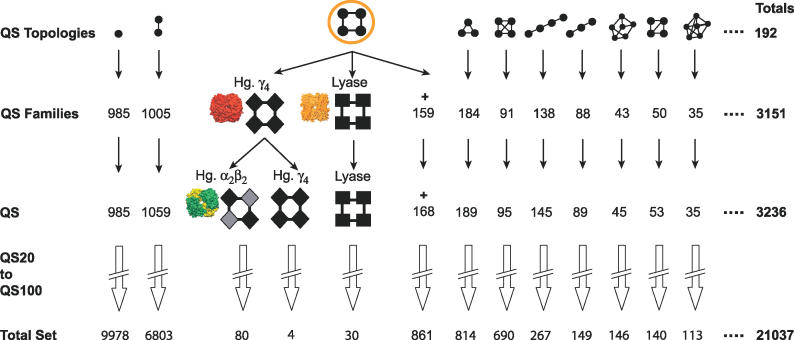
A Hierarchy of Protein Complexes of Known Three-Dimensional StructureThe hierarchy has 12 levels, namely, from top to bottom: QS topology, QS family, QS, QS20, QS30…QS100. At the top of the hierarchy, there are 192 QS topologies. One particular QS topology (orange circle) with four subunits is expanded below. It comprises 161 QS families in total, of which two are detailed: the E. coli lyase and the H. sapiens hemoglobin γ4. All complexes in the E. coli lyase QS family are encoded by a single gene and therefore correspond to a single QS. However, the hemoglobin QS Family contains two QSs: one with a single gene, the hemoglobin γ4, and one with two genes, the hemoglobin α2β2 from H. sapiens. The last level in the hierarchy indicates the number of structures found in the complete set (PDB). There are 30 redundant complexes corresponding to the lyase QS, four corresponding to the hemoglobin γ4 QS, and 80 to the hemoglobin α2β2 QS. We also see that there are 9,978 monomers, 6,803 dimers, 814 triangular trimers, etc. Note that there are intermediate levels using sequence identity thresholds (fourth to twelfth level) between the QS level and the complete set, which are not shown in detail here.